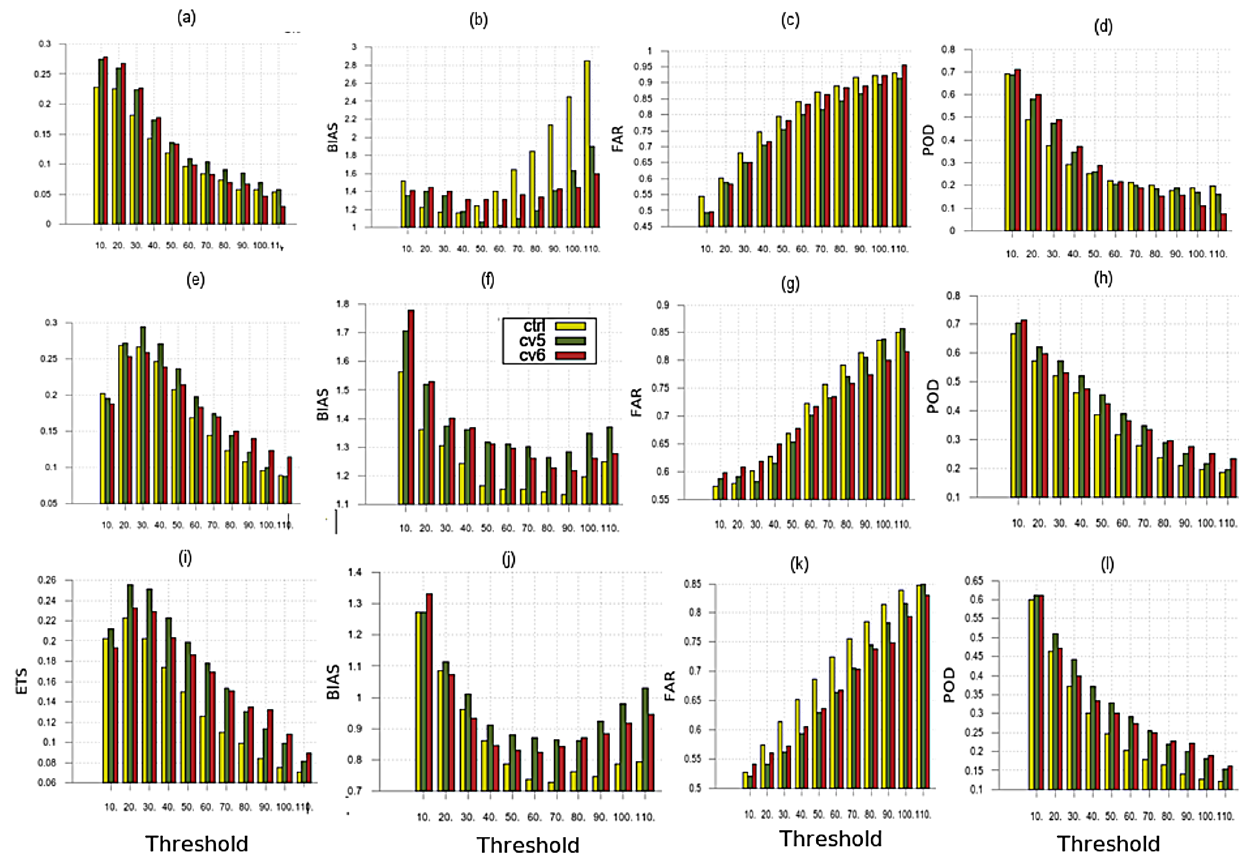
Figure 9. Skill scores of 48h accumulated precipitation (mm) with regard to TRMM for case 1 (a–d) , case 2 (e–h) and case 3 (i–l) depres- sions. Equitable threat score is shown in (a, e, i) . Bias scores (b, f, j) , false alarm ratio (c, g, k) and probability of detection (d, h, l)